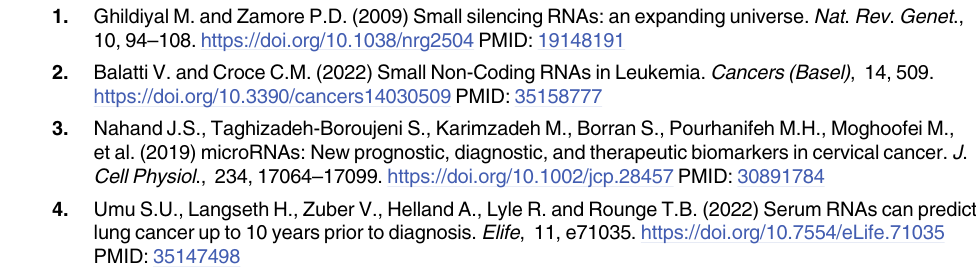
S1 Fig. Schematic illustration of ligation strategies of TruSeq, Low-Bias seq and SR-Cat/ SR-Cat-Amp seq. (TIF) S2 Fig. SR-Cat-Amp libraries preserve pore function longer than SR-Cat libraries. Cumula- tive number of reads sequenced is shown on the y-axis vs time in hours on the x-axis, each line represents an individual MinION flow cell. (TIF) S1 Table. Oligos used in this